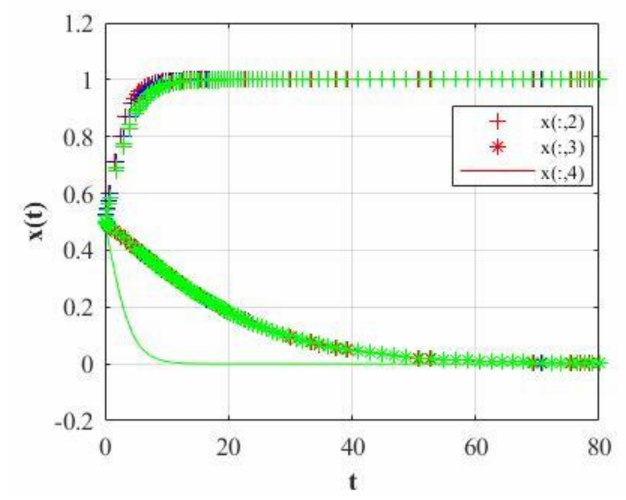
Figure 21. Change the parameter δ 2 = 0.2 (red curve), 0.6 ((blue curve), 0.9 (green curve) to take the value of the three-way strategy evolution diagram.